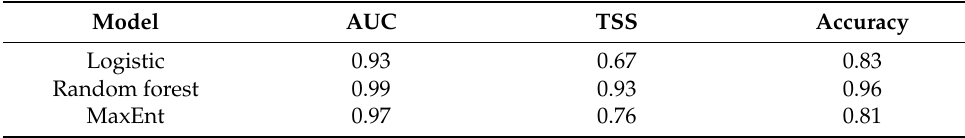
Table 9. Validation metrics used for comparison